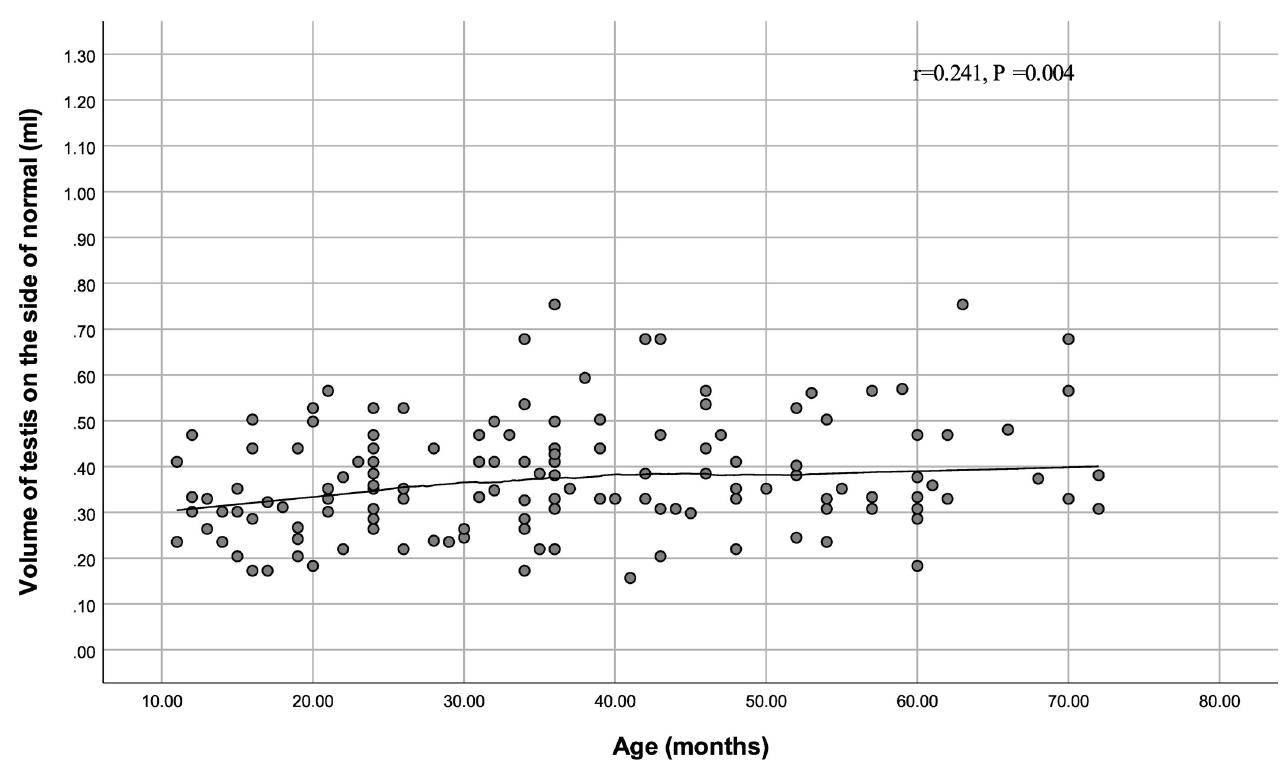
Fig 2. Scatter plot of age and volume of testis on the normal